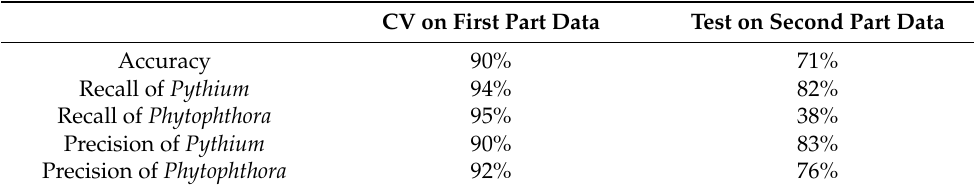
Table 2. Results of multiclass target classification. Two methods calculate various machine learning models’ performance measures: cross-validation performed on the data collected in the first part of the experiment and tested on the separate dataset of observations collected in the second part of the experiment.